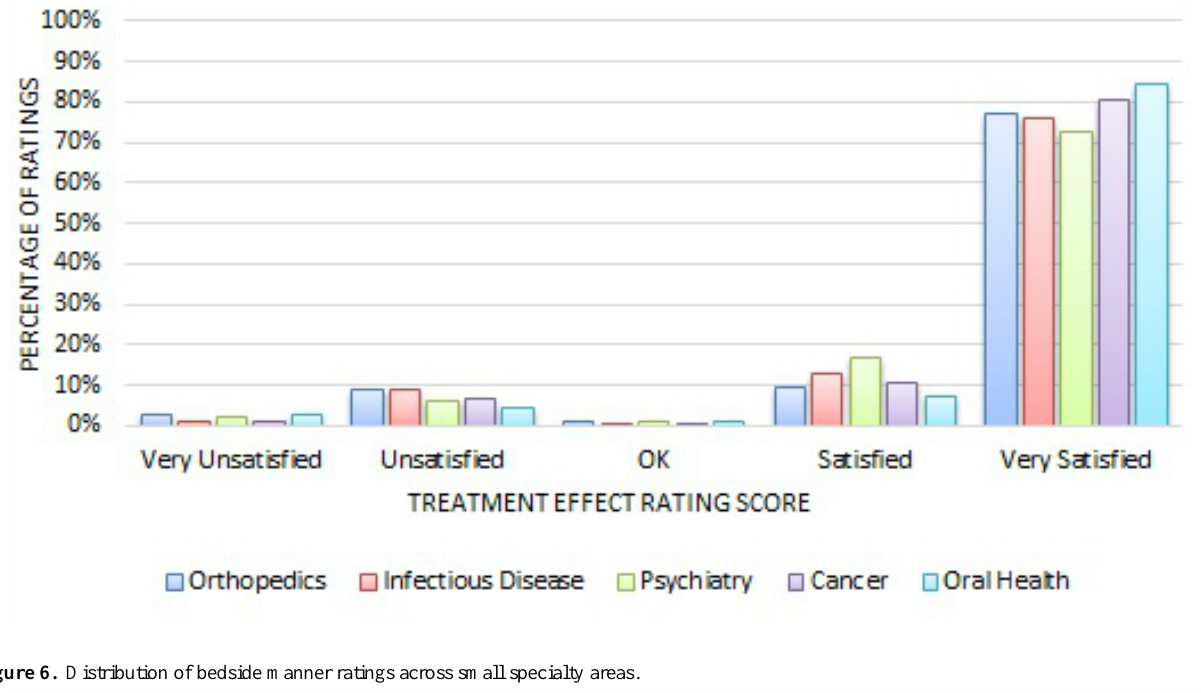
Figure 5. Distribution of treatment effect ratings across small specialty areas.